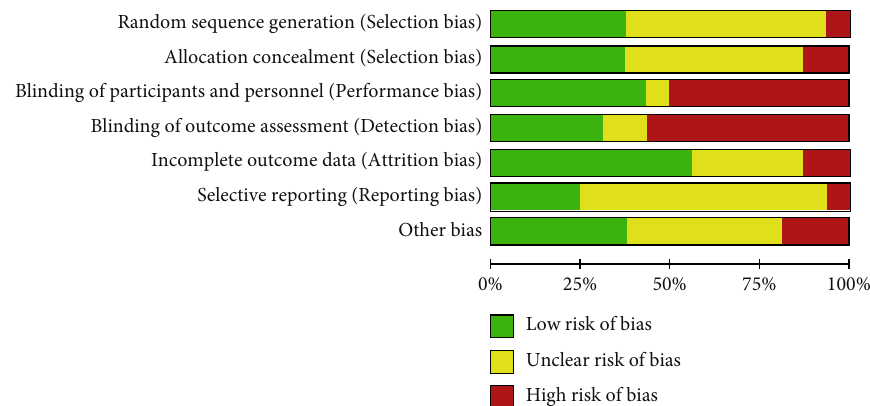
Figure 6: Risk of bias graph: review authors ’ judgments about each risk of bias item presented as percentages across all included